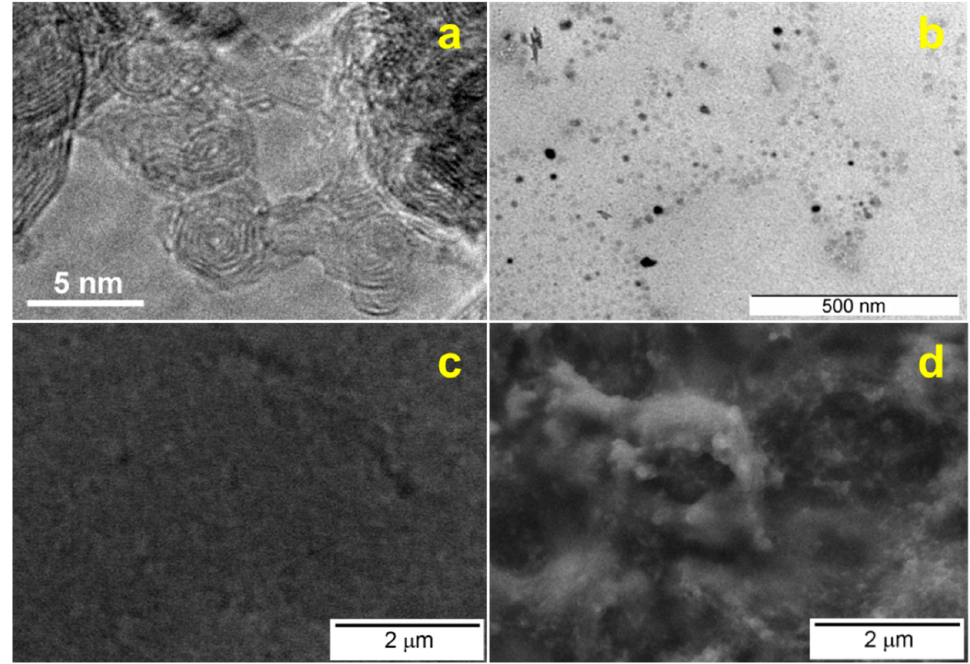
Figure 4. ( a ) HRTEM image of the starting CNOs. ( b ) TEM image of the CD/CNO/HRP composite before deposition on the SPEs. ( c ) ESEM image of the bare SPE and ( d )